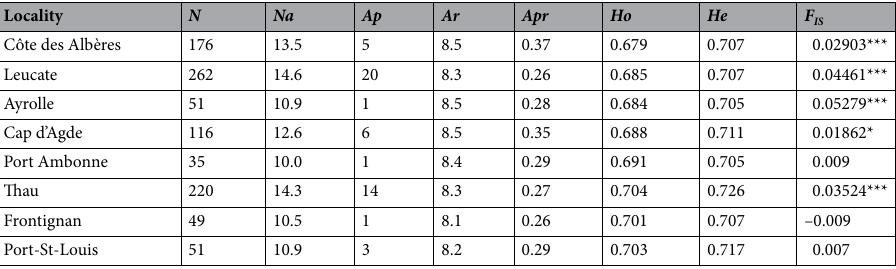
Table 2. Summary statistics of genetic diversity indices of Pinna nobilis in each locality. Significant values of F IS are indicated with *p-value < 0.05; **p-value < 0.01; ***p-value < 0.001. N number of individuals sampled, Na mean number of alleles, Ap number of private alleles, Ar standardized allelic richness, Apr